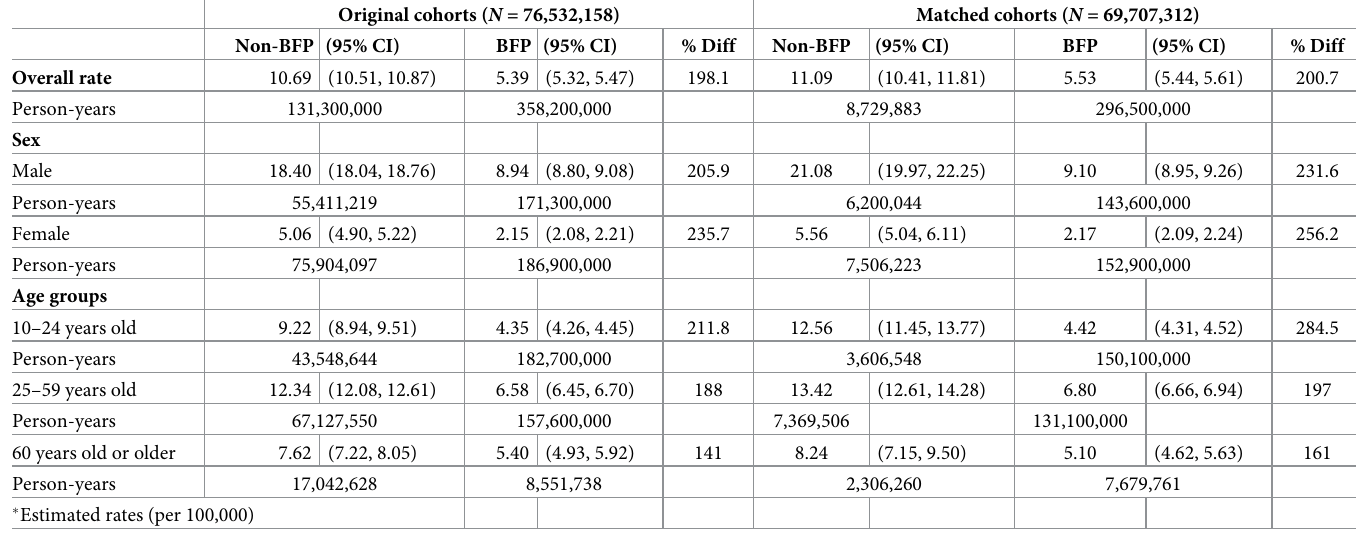
Table 2. Incidence of suicide rate for BFP participation, overall, by sex and age group, in the original and matched cohorts from 2004–2015. Original cohorts ( N = 76,532,158) Matched cohorts ( N = 69,707,312) Non-BFP (95%